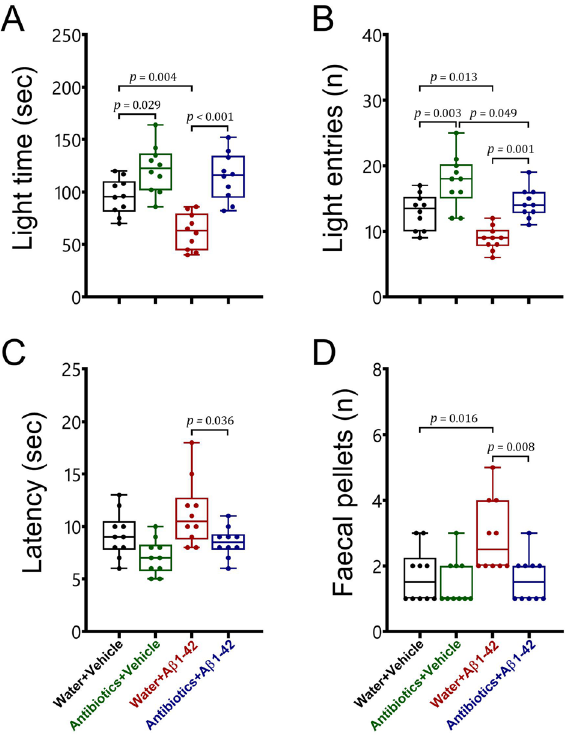
Figure 2. The effects of antibiotic treatment alone or in combination with Aβ1–42 treatment on anxiety-related behaviour in male C57BL6 mice. To examine anxiety-related behaviour, animals were subjected to the light– dark box ( A light time; B light entries; C latency; D faecal pellets). Data are expressed as mean ± SEM (n = 10). Antibiotic treatment significantly increased the time spent [ p = 0.029] and the number of entries [ p = 0.003] in the light area, whereas it did not affect the latency and faecal pellets [ p > 0.05] in the light–dark box, as compared to the water + vehicle group. On the other hand, Aβ 1–42 administration significantly reduced the light time [ p = 0.004] and entries [ p = 0.013], and increased fecal pellets [ p = 0.016; D ] in water-treated mice, as compared to the water + vehicle group. In addition, Aβ 1–42 treatment significantly decreased the light entries [ p = 0.049], but not the other behavioral parameters [ p > 0.05] in antibiotic-treated mice relative to the antibiotics + vehicle group. However, we did not detect any significant differences in all behavioural parameters in the light–dark task between antibiotics + Aβ 1–42 mice and water + vehicle group [ p > 0.05]. On the other side, significant differences in the light time [ p < 0.001], the light entries [ p = 0.001], the latency [ p = 0.036], and faecal